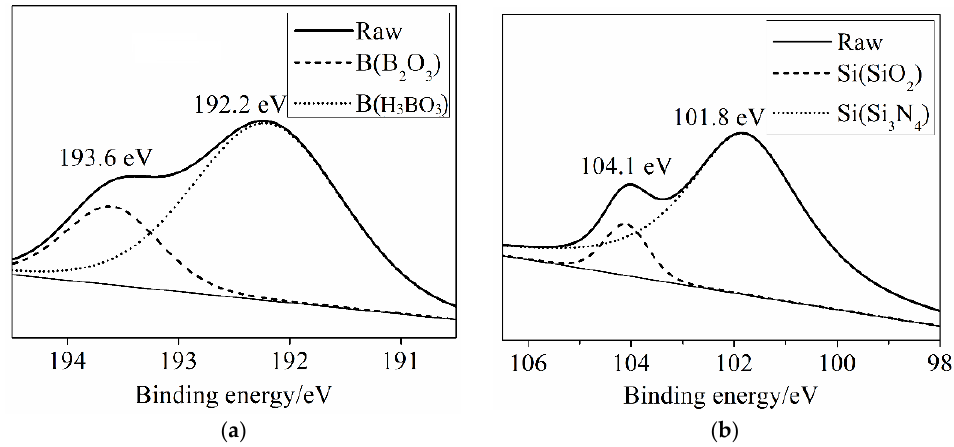
Figure 7. Binding energy on the worn surface of SN20 pin against UHMWPE disc in SBF: ( a ) B 1s and ( b ) Si 2p.